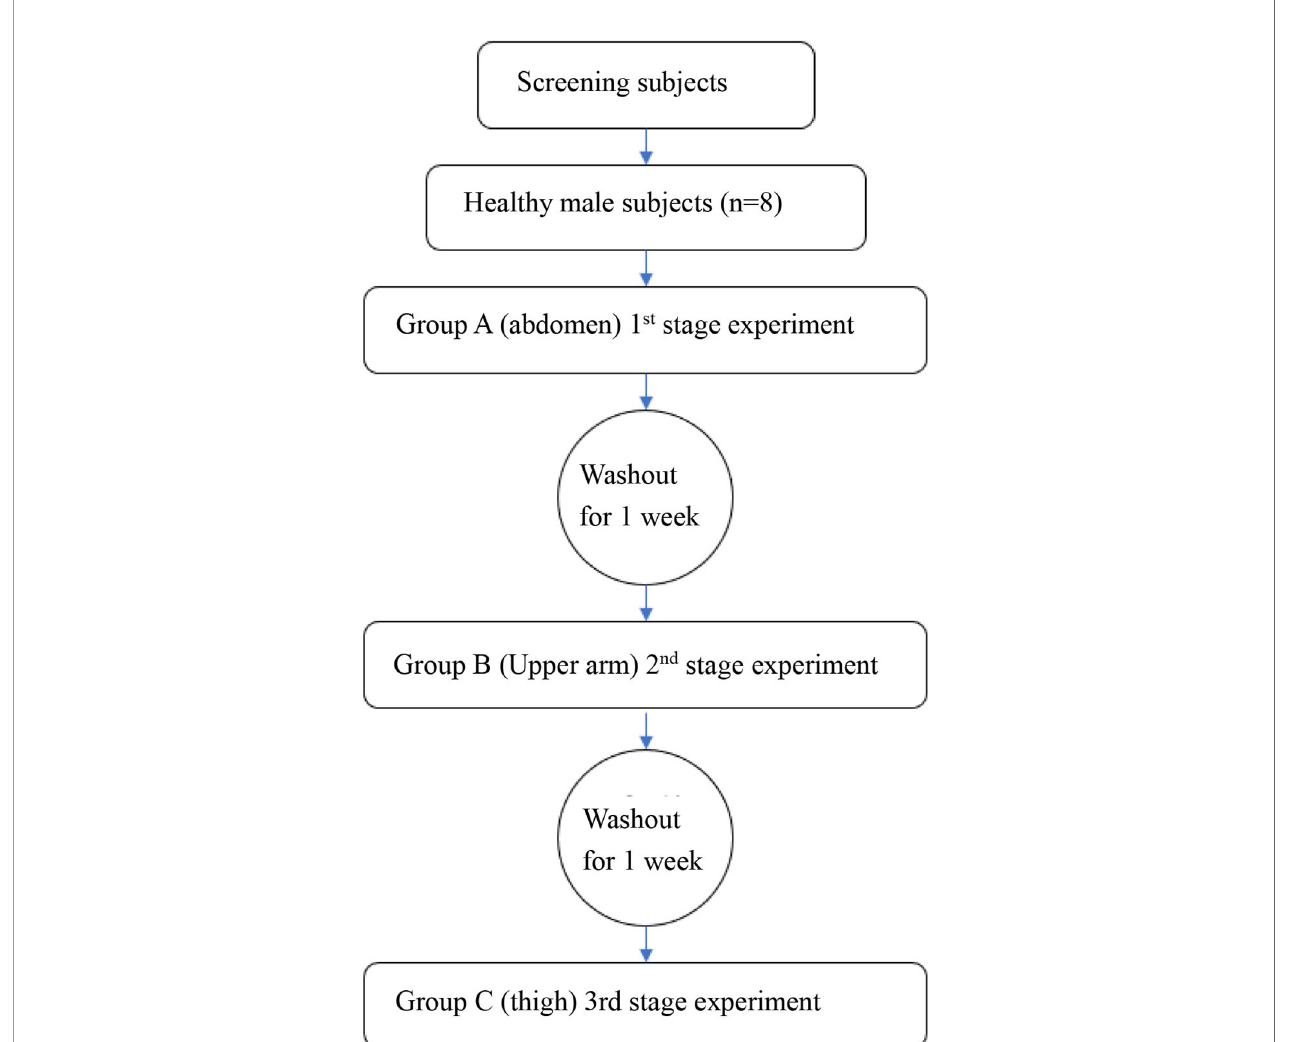
FIGURE 1 | The overall research step. The machines and methods for measuring skin were supplemented. A Samsung RS-80A ultrasonic diagnostic instrument and a L3-12AMHz linear array probe were applied for exploration. All subjects took the supine position, and the skin thickness was measured on the upper abdomen, lateral upper arm, and lateral